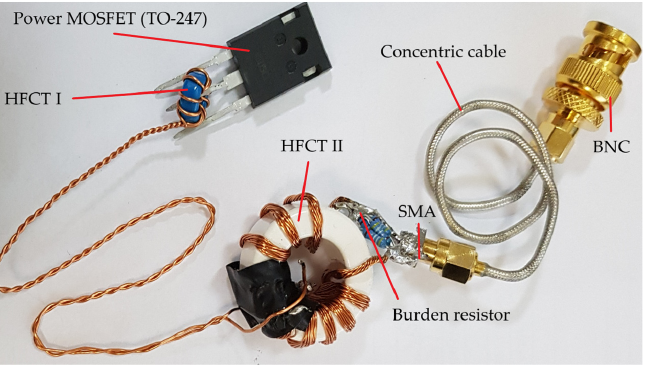
Figure 7. The proposed current sensors with dual connection of two HFCT—cascaded connection. Table 2. Measured parameters of the HFCT I.